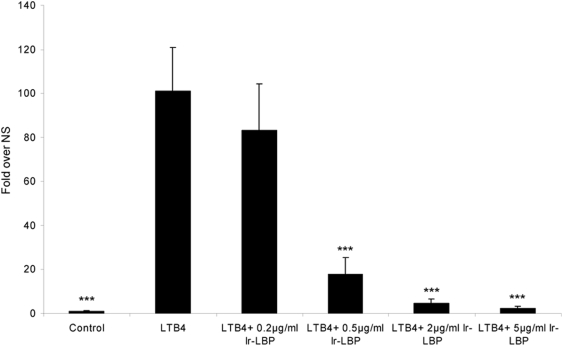
Ir-LBP effect on transendothelial migration of freshly isolated neutrophils stimulated by LTB4.Results represent the number of cells that cross the endothelial barrier after 2 h. Results were obtained from two independent experiments and are expressed as a fold increase over control. One LTB4 concentration and four Ir-LBP concentrations, 10E−7 M and a range from 0.2 µg/ml to 5 µg/ml respectively were used.